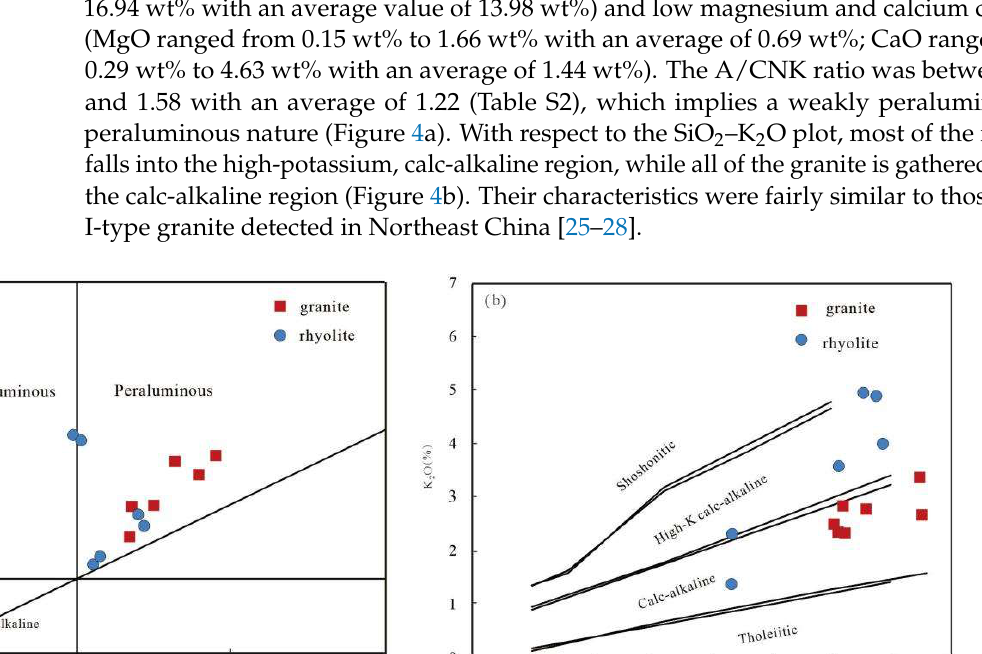
Figure 5. ( a ) The chondrite normalized REE pattens for the Early Cretaceous magmatic rock from the Badaguan area, modified from Boynton [32] and ( b ) the primitive mantle normalized trace ele- ment spider diagrams for the Early Cretaceous magmatic rock from the Badaguan area, modified from Sun and McDonough [33]. 4. Discussion 4.1. Age of Magmatic Rock Formation